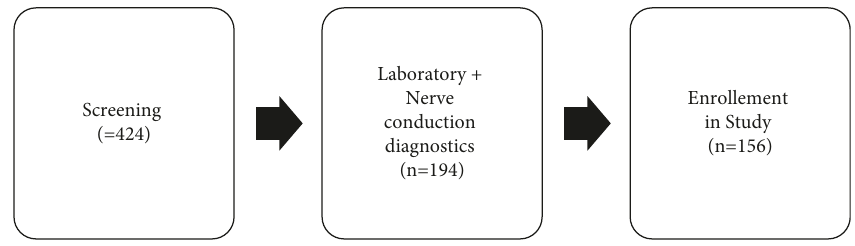
Figure 1: Flowchart of the inclusion process of Table 1: Current medication of fibromyalgia patients (total number of patients � 156) and previously discontinued medication. Some of the patients took more than one medication.